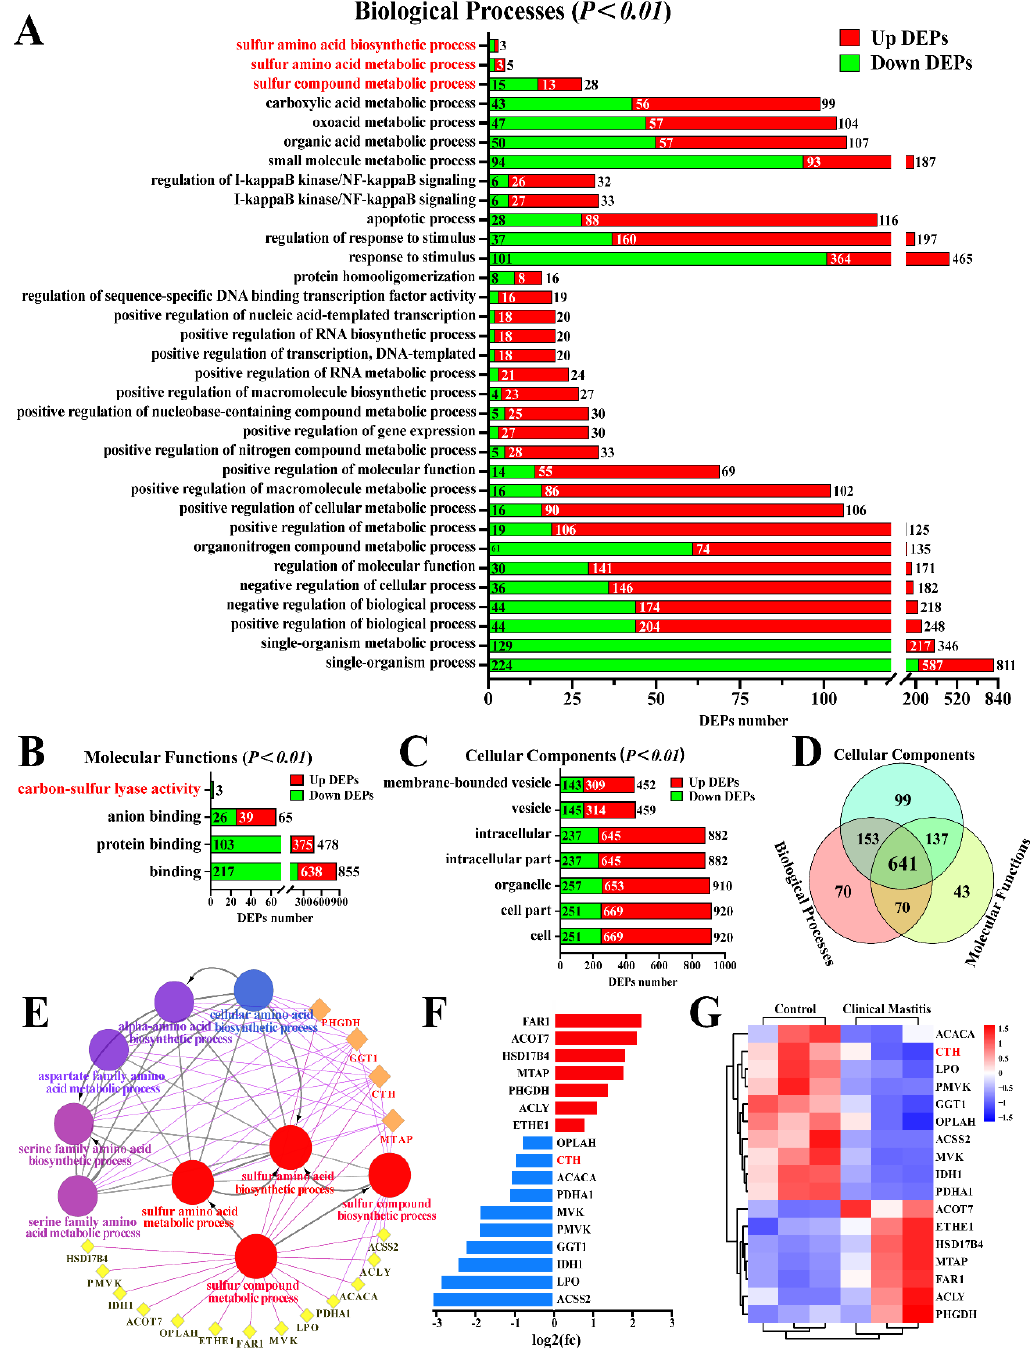
Figure 1. Identification of candidate DEPs and GO terms related to sulfur metabolism. ( A – C ) Can- didate DEPs and GO terms including biological process ( A ), molecular function ( B ) and cellular